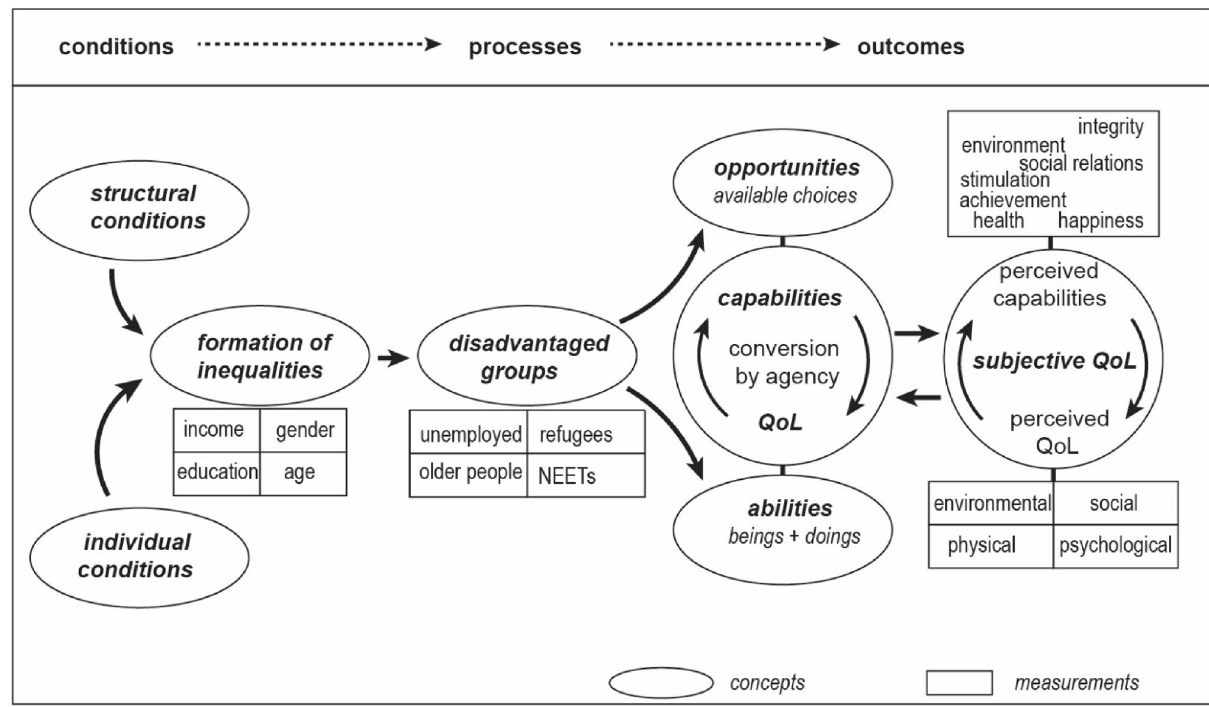
Figure 1. The Conceptual Model—capabilities as conversion factors between conditions and subjective